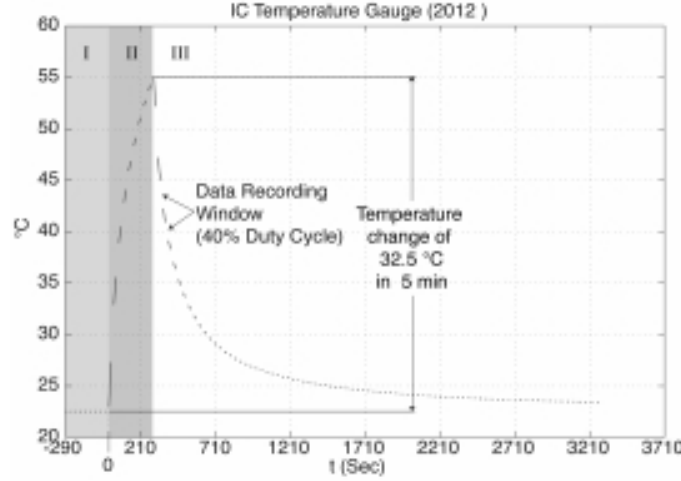
Fig. 2. Temperature Profile for Events 1 and 2.